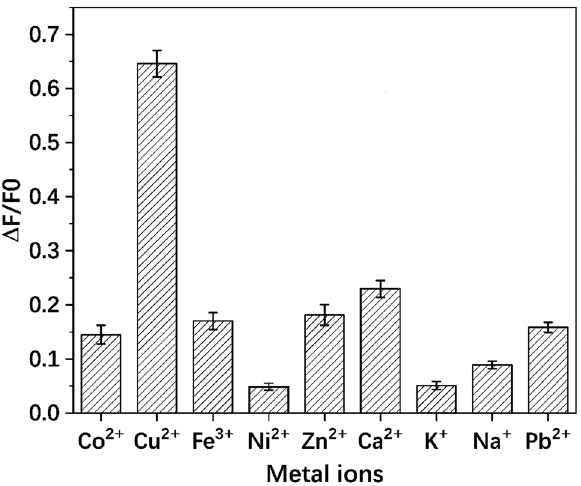
Figure 7. Fluorescence response of the CCYWDAHRDY-AuNCs upon the addition of various ions. The concentration of Cu 2+ was 60 μmol/L, and the concentration of other metal ions was 600